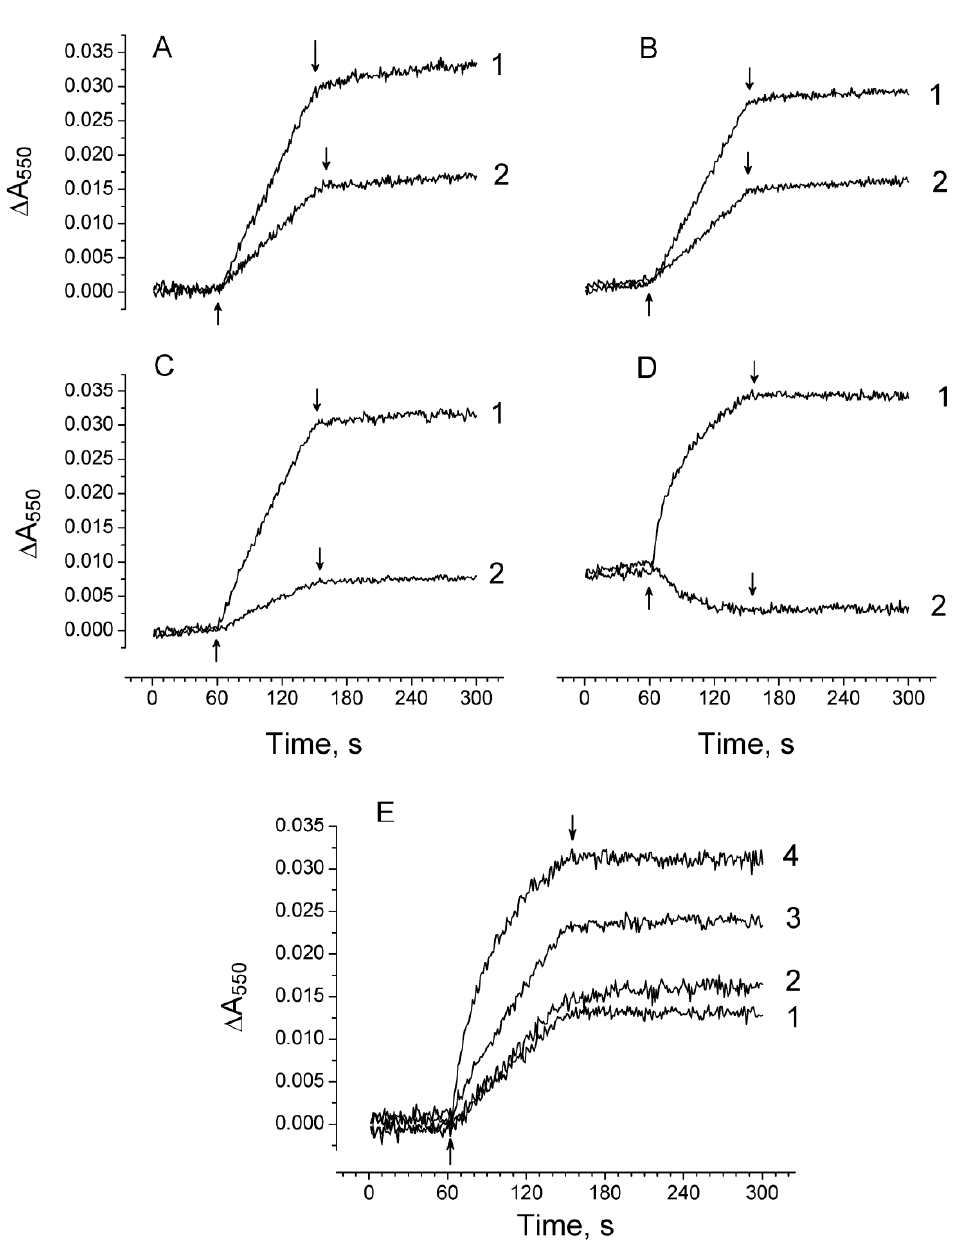
Figure 4. Kinetics of Cyt c photoreduction by PSII membranes before ( A ) and after modification of the water-oxidizing complex caused by treatments of NaCl ( B ), CaCl 2 ( C ), and NH 2 OH ( D ). The measurements were done in the absence of additions (1) and after the addition of 50 Un / mL SOD (2). Reaction medium contained 50 mM MES–NaOH (pH 6.5), 35 mM NaCl, 0.4 M sucrose, and 10 µ M Cyt c . The PSII membranes were illuminated ( λ > 600 nm, 1500 µ mol photon s − 1 m − 2 ) at chlorophyll concentration of 10 µ g / mL. Up and down arrows indicate light on and o ff , respectively. (E) Kinetics of Cyt c reduction associated with the light-induced O 2 −• formation in the PSII membranes before (1) and after modification of the water-oxidizing complex caused by treatments of NaCl (2), CaCl 2 (3) and NH 2 OH (4). The kinetics was obtained by the subtraction of the kinetics of Cyt c photoreduction measured in the presence of SOD from that measured in the absence of